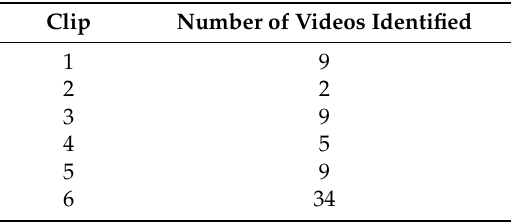
Table A3. Number of contests to meet the criteria for each video clip. Clip Number of Videos Identified